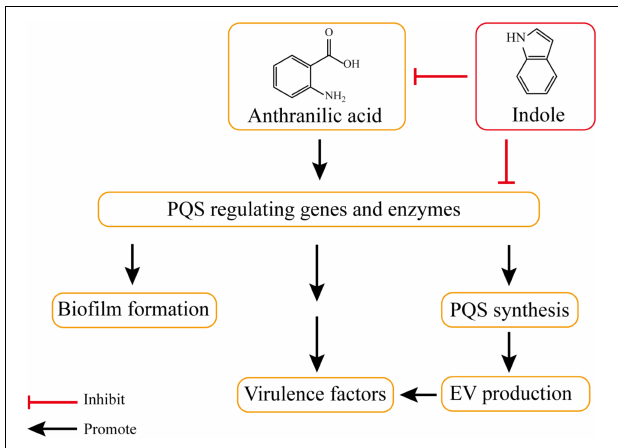
FIGURE 2 | Indole inhibits PQS synthesis and EV production. The production of PQS is initiated with anthranilic acid. PQS involves in the production of several bacterial virulence factors and biofilm formation, and it positively regulates the production of EV through gene regulation or enzymatic reactions. Indole can inhibit EV production by involving in the synthesis or the degradation of anthranilic acid and affecting the activation of PQS synthesis-related